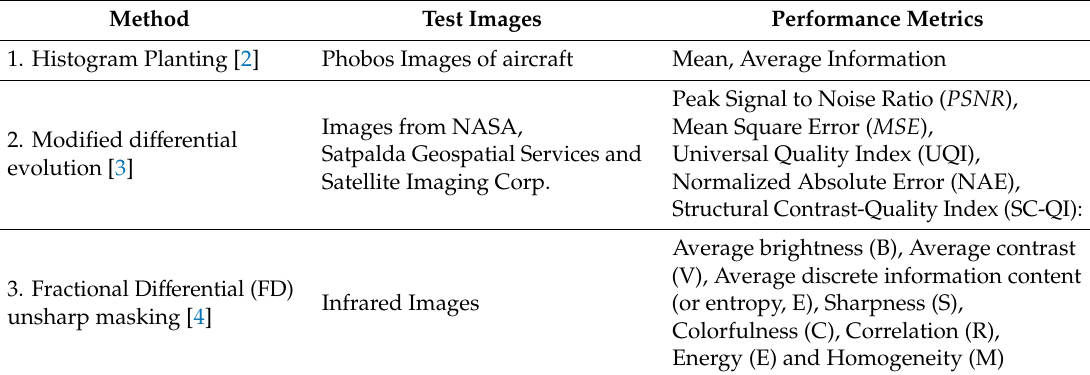
Table 1. Image Enhancement methods and their performance